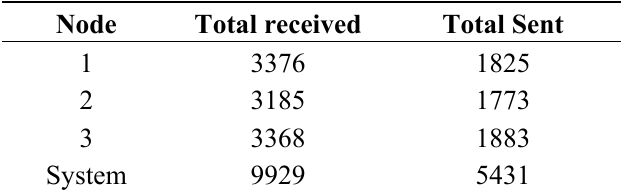
Table 4. Messages sent and received in the static test.